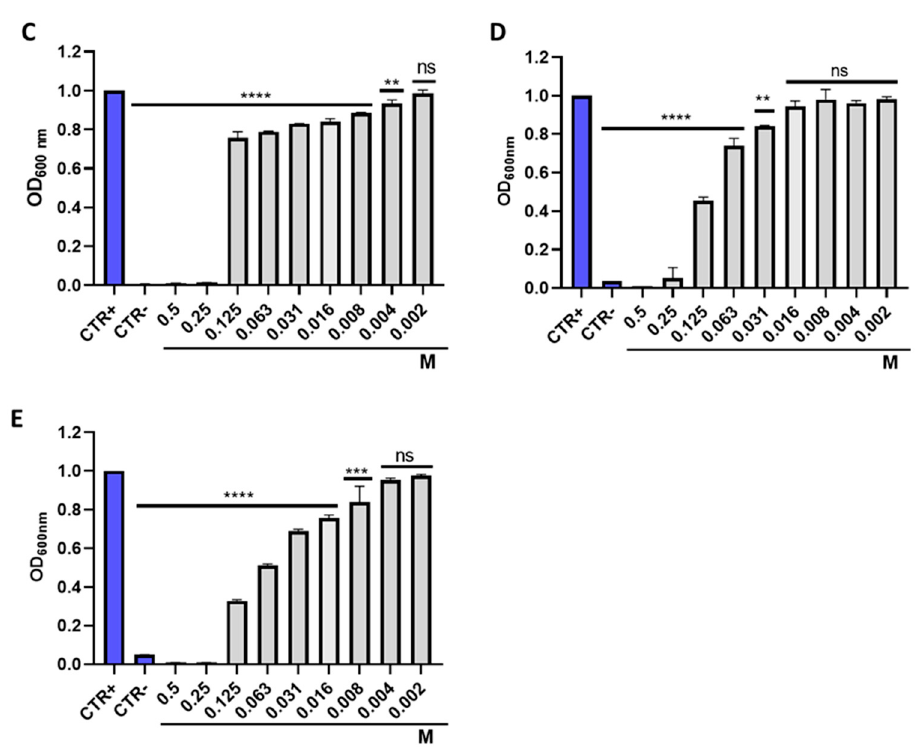
Figure 2. Antibacterial activity of IDSK at concentrations of 0.5 to 0.002 M on: ( A ) Escherichia coli ,